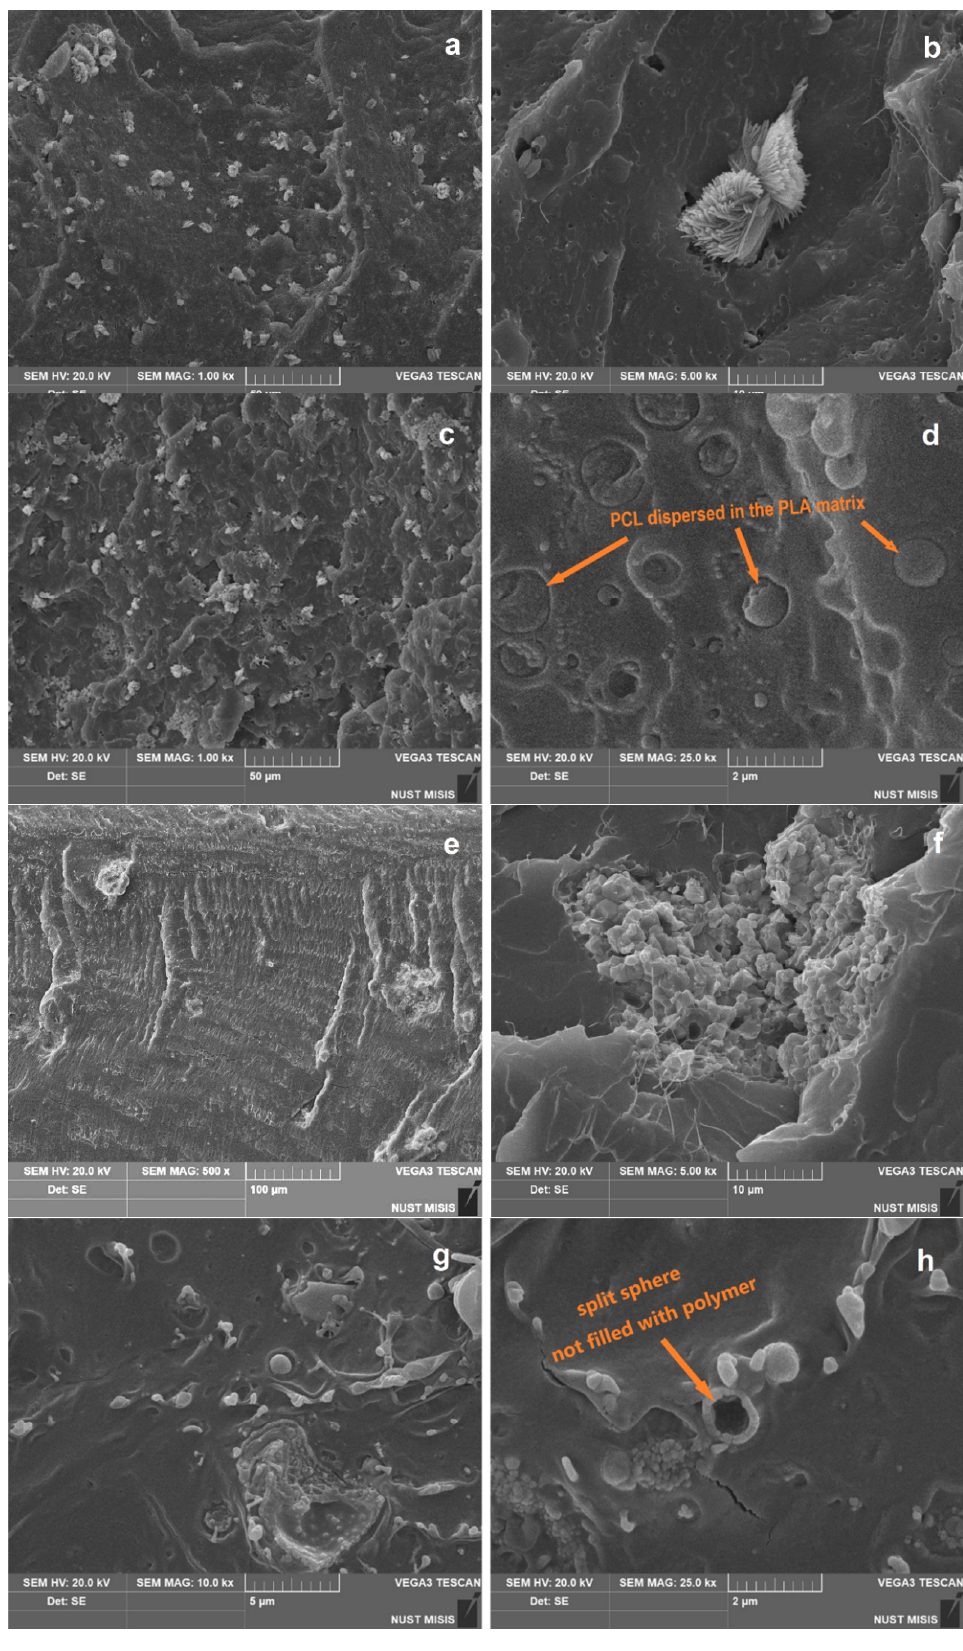
Figure 7. Morphology of cleavage of PLA-based composite: containing 10 wt.% CuSO 4 powder ( a , b ); containing 10 wt.% CuSO 4 and 5 wt.% PCL ( c , d ); containing 5 wt.% CuO powder ( e , f ); containing 5 wt.% CuO microspheres ( g , h ).